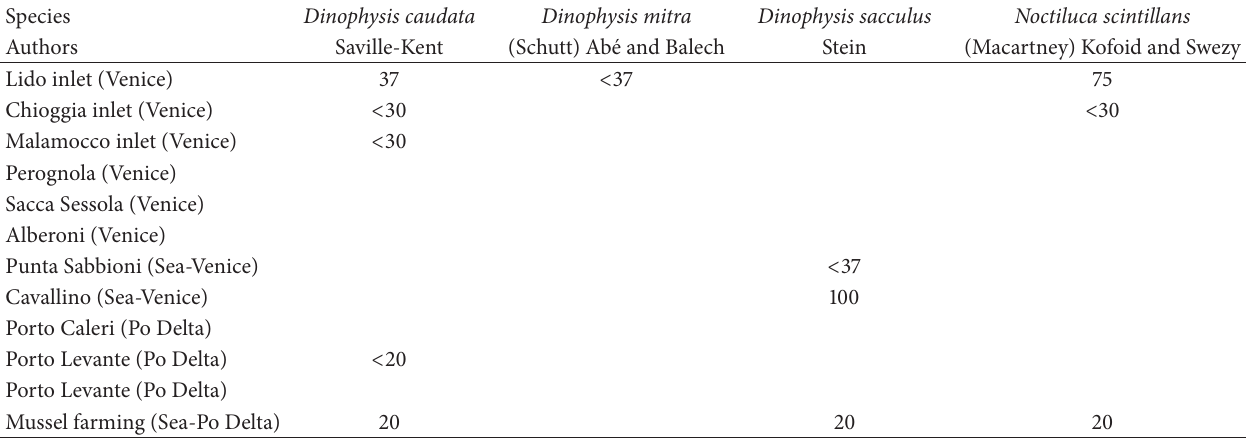
Table 2: Harmful algae occurrence in the study area. Cell abundance is expressed as